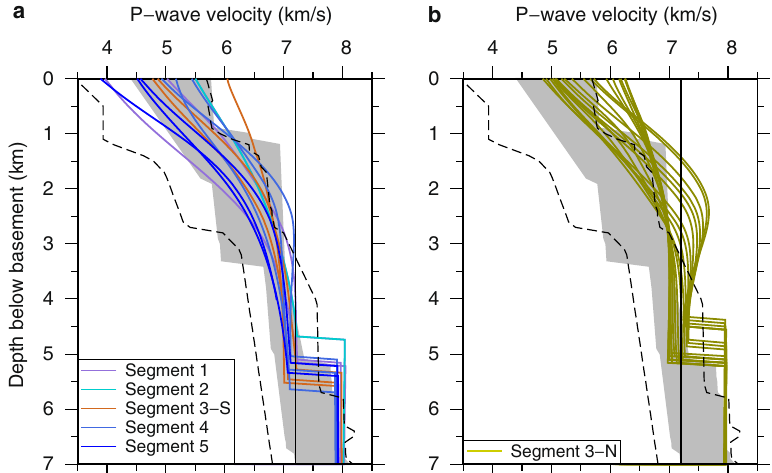
Fig. 4 | One-dimensional P-wave velocity-depth pro fi les. a Pro fi les extracted from Segments 1, 2, 3-S, 4, 5 (see the legends) with predominantly magmatic accreted crust. b Pro fi les extracted from Segment 3-N with predominantly tecto- nicallyformedcrust.Theblackdashedlinesrepresentthevelocityenvelopeforthe